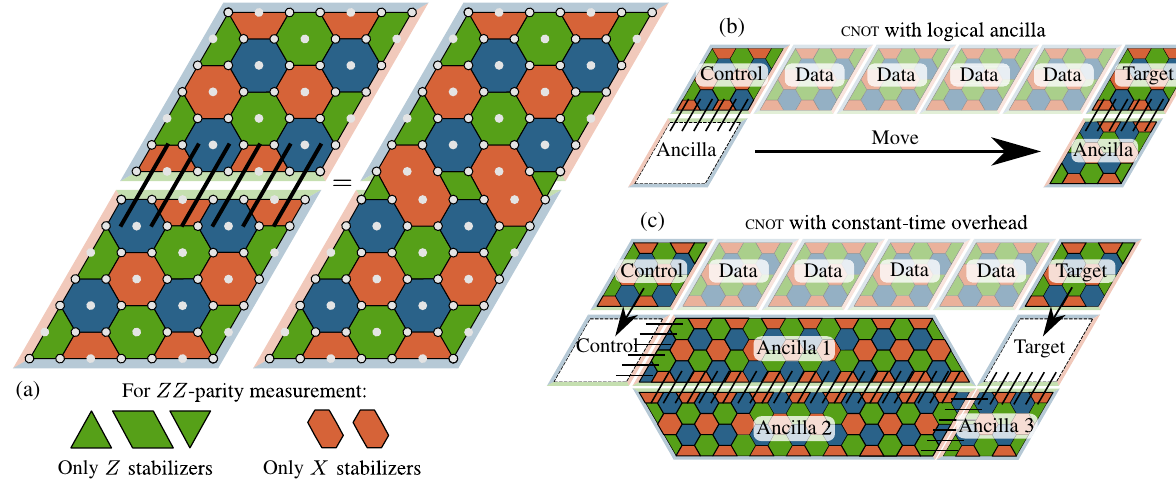
FIG. 10. (a) Fault-tolerant ZZ -parity ( XX -parity) measurement between two diamond color-code qubits by lattice surgery [34], denoted by black lines crossing the neighboring boundaries. First, new three- and four-qubit green stabilizers are introduced, and new eight-qubit stabilizers are obtained by merging red plaquettes along the boundary. These stabilizers are measured along with all other stabilizers in order to obtain the ZZ parity ( XX parity), where the new green boundary stabilizers are only measured in the Z basis ( X basis) and the red eight-qubit stabilizers only in the X basis ( Z basis). (All stabilizers are explicitly shown in Fig. 21 in Appendix C.) The product of the green boundary stabilizers is precisely the two-qubit parity. Finally, the stabilizers are returned to their initial configuration before the lattice surgery. (b) Protocol for a fault-tolerant CNOT using lattice surgery. A logical ancilla is initialized in the jþi state. The ZZ parity between the control and ancilla is measured, and the ancilla is moved through the CNOT bypass to the target. Finally, the XX parity between the ancilla and target is measured, and the ancilla is read out. The length of this protocol scales linearly with the distance between the control and target. (c) Lattice-surgery-based CNOT protocol with constant-time overhead. The ZZ parities between the control and three ancilla qubits in the jþi state are measured simultaneously using the three lattice surgeries indicated in the figure. Next, the XX parity between ancilla 3 and the target is measured. Finally, ancilla 3 is read out in the Z basis, while ancillas 1 and 2 are measured in the X basis. In the presence of measurement errors during syndrome read-out, this protocol scales logarithmically with the distance between the control and